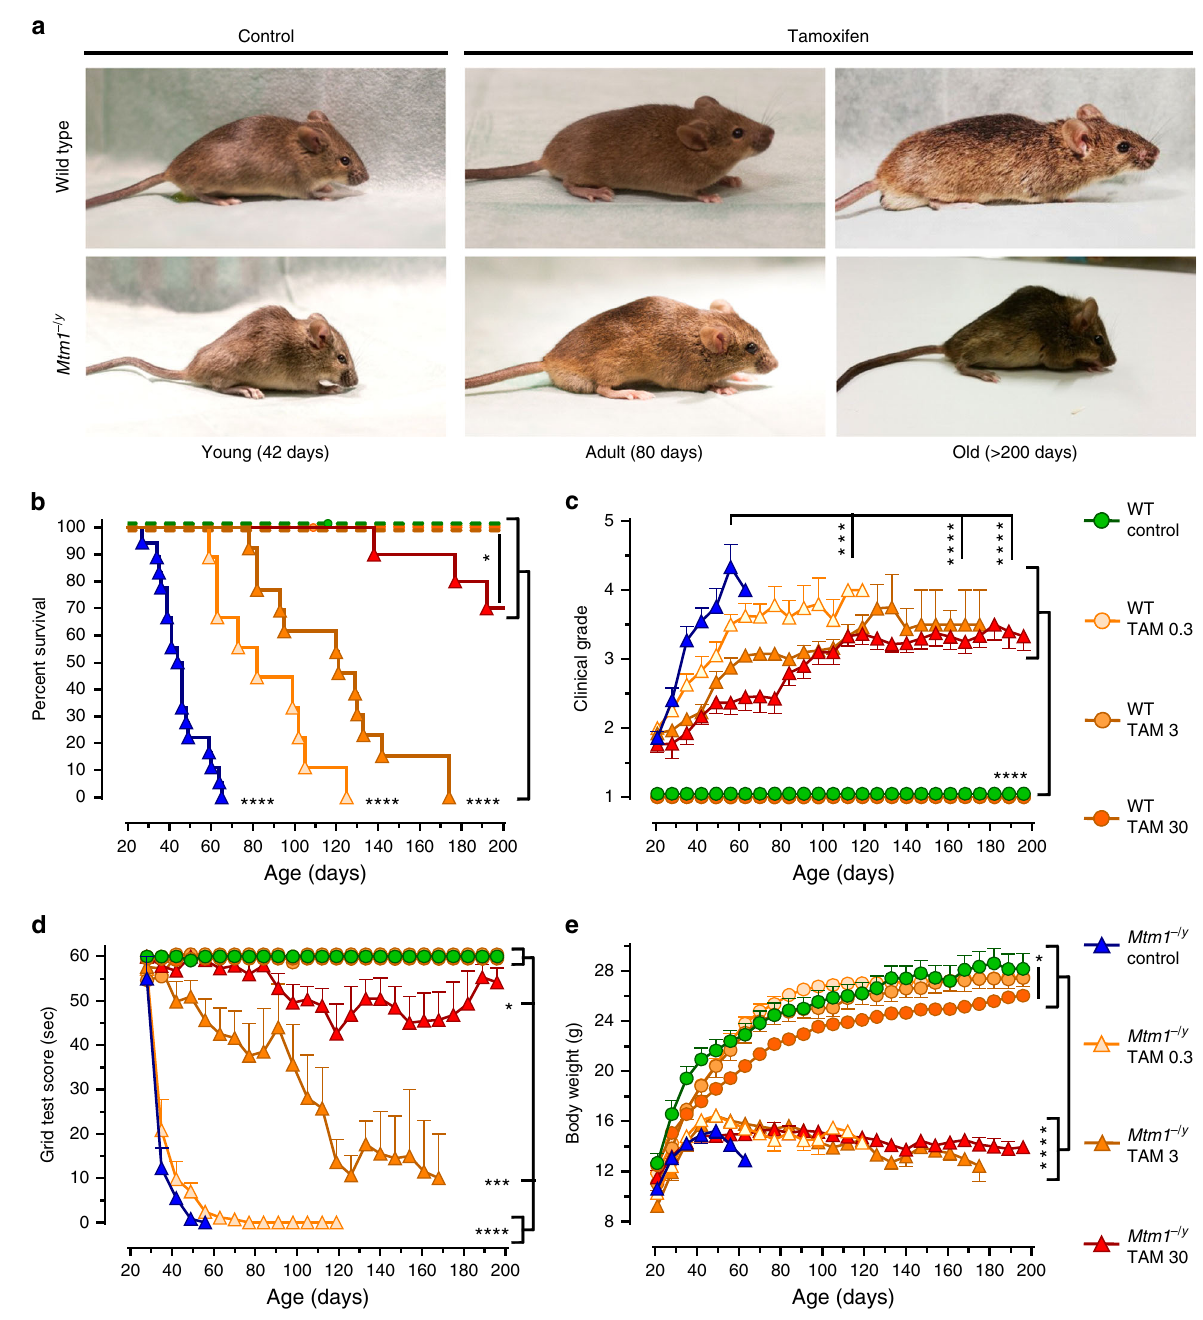
Fig. 1 Tamoxifen rescues the phenotype of XLMTM mice. Life-long oral tamoxifen delays disease progression in XLMTM mice. Wild type (WT) and Mtm1 − /y mice were fed control or tamoxifen (TAM)-supplemented diets from weaning onward. a Photographs of WT and Mtm1 − /y mice, illustrating disease severity in young untreated mice and protection conferred by tamoxifen in adult and old mice. b Kaplan – Meier curves showing the effects of treatments on mouse survival. Early death of untreated Mtm1 − /y mice contrasts with prolongation of life span in tamoxifen-treated littermates. Data are from 8 to 18 mice per group. * P ≤ 0.05; **** P ≤ 0.0001. Log-rank (Mantel – Cox) test. c Disease progression was assessed three times per week using a 5-grades clinical scale: muscle function was scored as 1 (normal function of hind limbs), 2 (dif fi culty in spreading toes), 3 (evident weakness in legs), 4 (paralysis of one hind limb), or 5 (complete paralysis of both legs). WT mice had a clinical score of 1 (normal) throughout the study. Untreated Mtm1 − /y mice quickly reached a high clinical grade, whereas disease progressed much slower in tamoxifen-treated littermates. d Mouse motor function was assessed weekly via a horizontal grid-hanging test. The score of untreated Mtm1 − /y mice declined quickly. Tamoxifen preserved motor function of Mtm1 − /y mice close to WT values. e Mouse body weight was recorded 3 times per week. Tamoxifen affected the growth of WT but not of Mtm1 − /y mice. Mtm1 − /y mice remained smaller than WT mice throughout. b – e Symbols and TAM doses (0.3, 3, and 30 mg kg − 1 of diet) are shown on the right-hand side. c , d , e Data represent the mean ± s.e.m. of 8 to 18 mice as de fi ned in a . * P ≤ 0.05; ** P ≤ 0.01; **** P ≤ 0.0001; ns non-signi fi cant. One-way ANOVA with Fisher ’ s least signi fi cance difference (LSD)